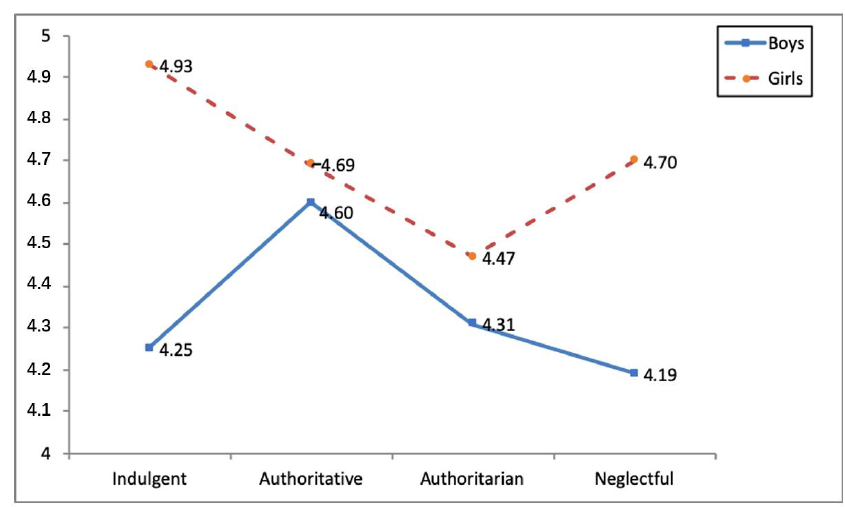
Figure 1. Interaction effect parenting style x gender and social integration.